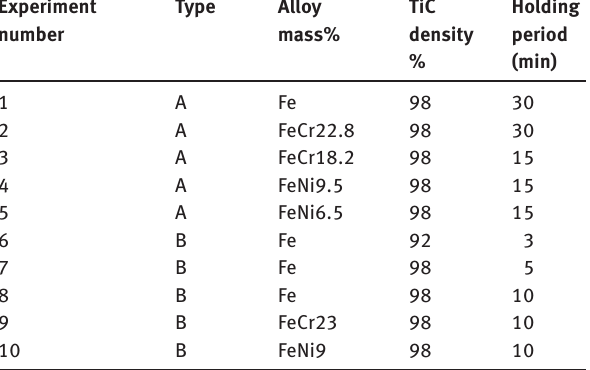
Fig. 4: Contact angle vs. time for type B